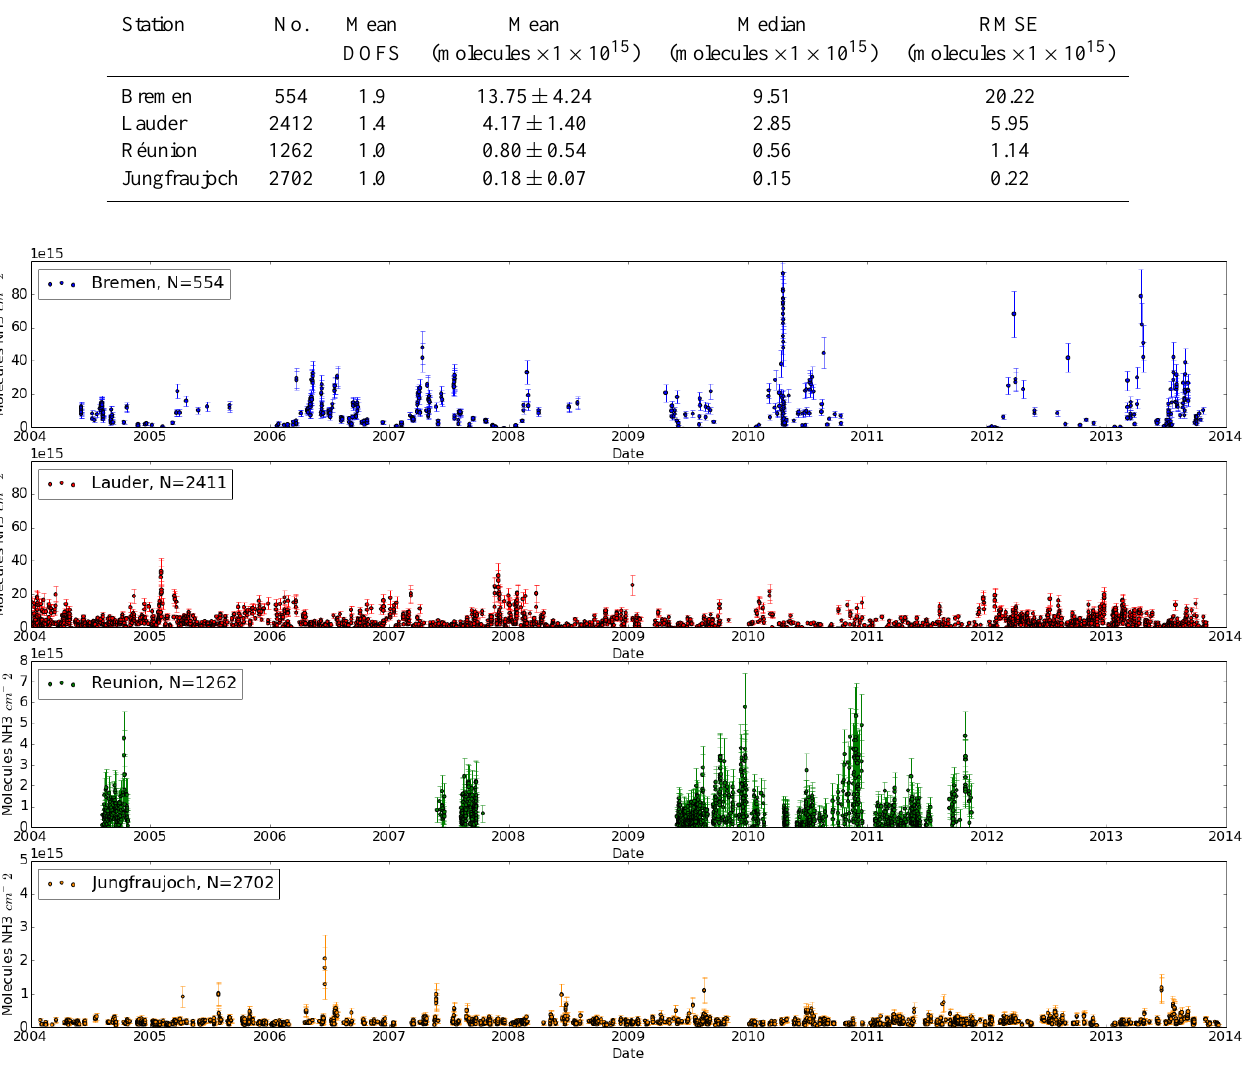
Table 5. Statistics of the NH 3 columns. (No.: number of data points, DOFS: degrees of freedom of signal, mean ± the error of the mean,